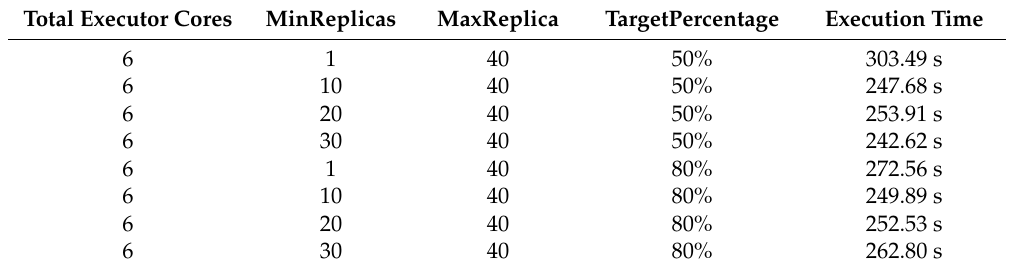
Table 5. The impact of different auto-scaling strategies to the efficiency of SNNQAs using